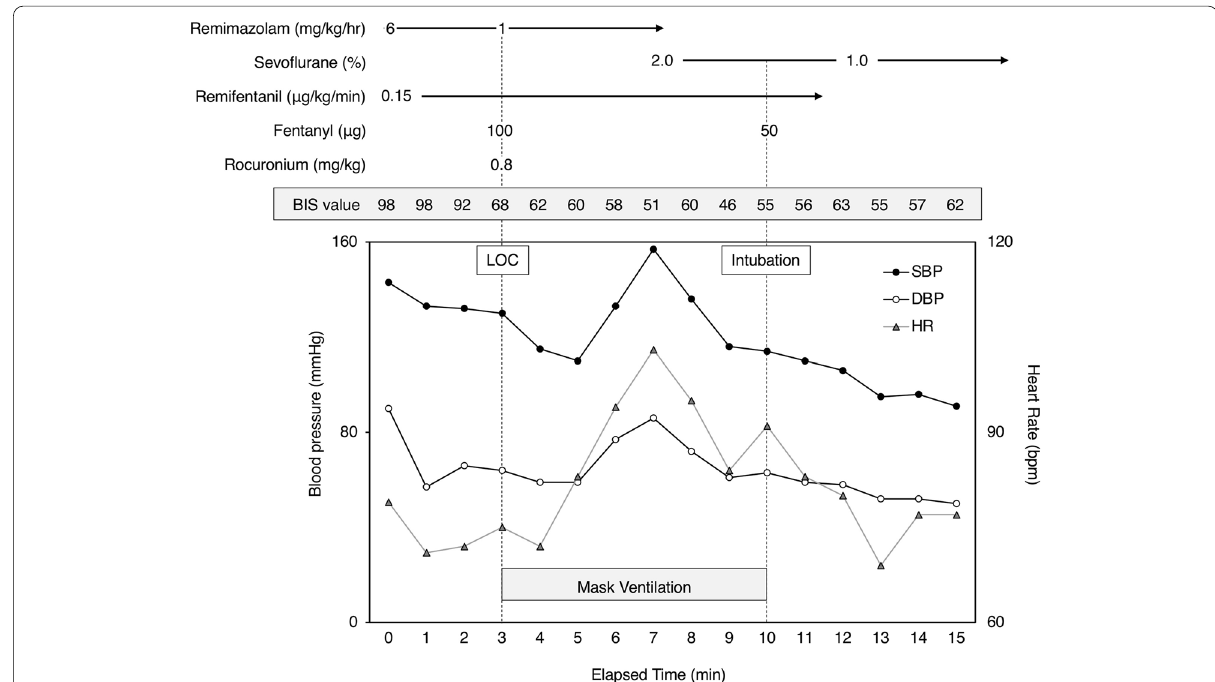
Fig. 1 Anesthetic chart during anesthetic induction. LOC, loss of consciousness; BIS, bispectral index; SBP, systolic blood pressure; DBP, diastolic blood pressure; HR, heart